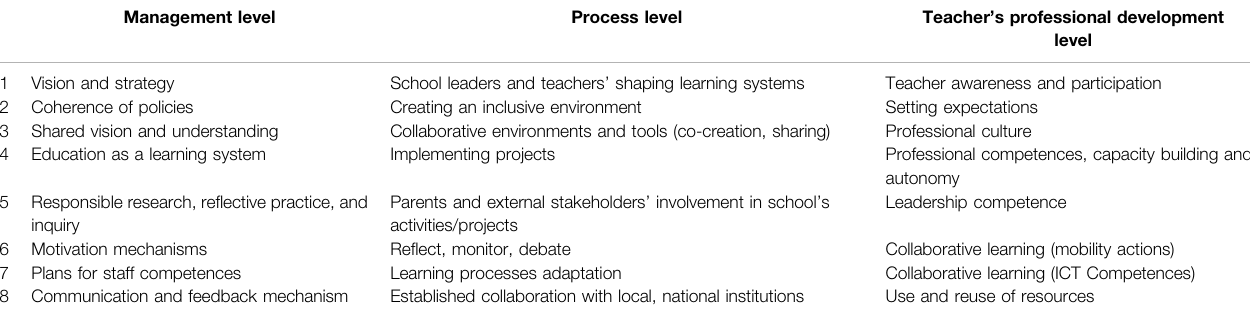
TABLE 1 | The eight items in each one of the three levels of openness, 24 task-speci fi c statements in